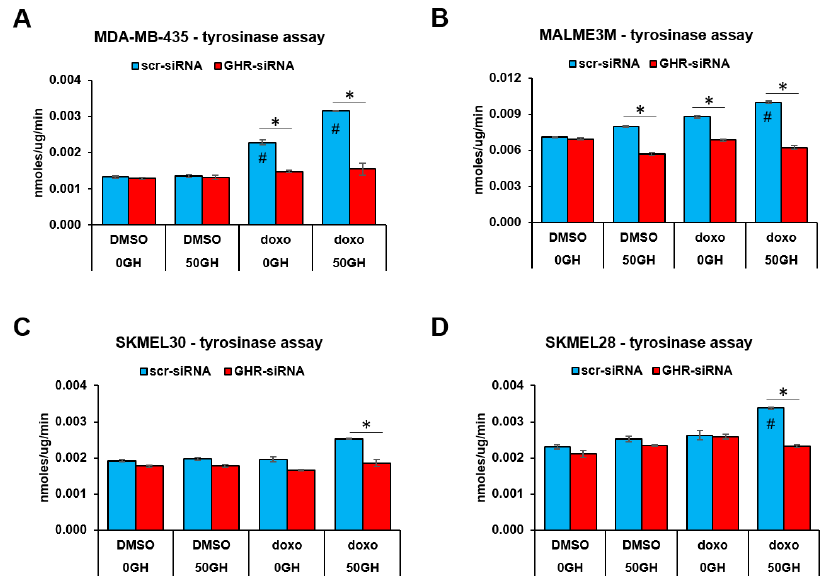
Figure 5. GH enhances MITF-regulated tyrosinase activity in human melanoma cells. Changes in tyrosinase activity in 25 µ g cell lysates of ( A ) MDA-MB-435, ( B ) MALME-3m, ( C ) SK-MEL-30, and ( D ) SK-MEL-28 cells treated with / without 50 ng / mL recombinant human growth hormone in presence / absence of doxorubicin and siRNA-mediated GHRKD. After 48 h treatment, total protein was extracted and quantified by Bradford assay. Tyrosinase assay was performed using a commercial kit (BioVision) following manufacturer’s protocol (#,*, p < 0.05, Students t test, n = 3; # indicates comparison against untreated (-GH, -dox, -GHRKD) control).